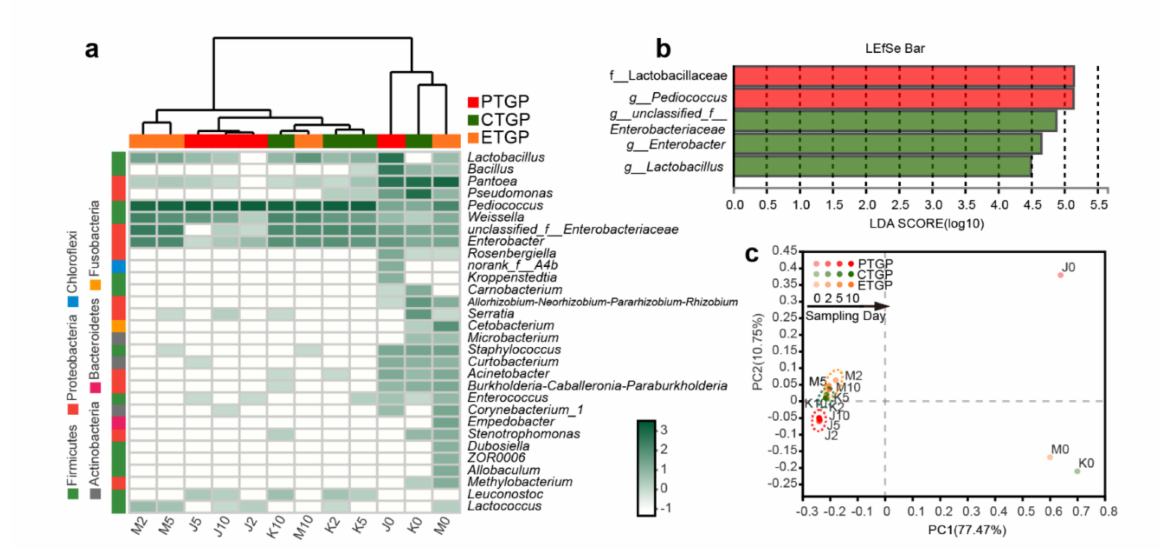
Figure 2. The bacterial community succession was associated with exogenous probiotics and enzymes during fermentation. ( a ) Heat maps showing the relative abundance of the top 30 bacterial genera in the fermented feed; the color intensity presents the log-transformed value of standardized reads. ( b ) Linear discriminant analysis (LDA) coupled with the effect size measurements identifies the significant abundance of data in ( a ); LDA significant threshold was >4.0. ( c ) Principal coordinate analysis based on bacterial OTU levels. The numbers following the J/K/M indicate the sampling time (day) of PTGP/CTGP/ETGP.